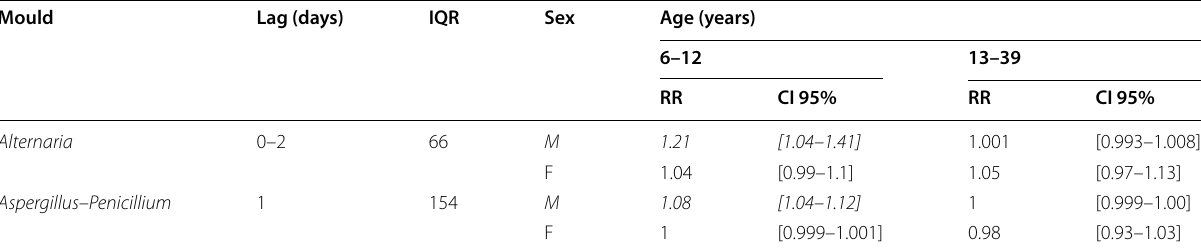
Table 2 Outdoor moulds and SABA sales by age and gender, 2010–2012,